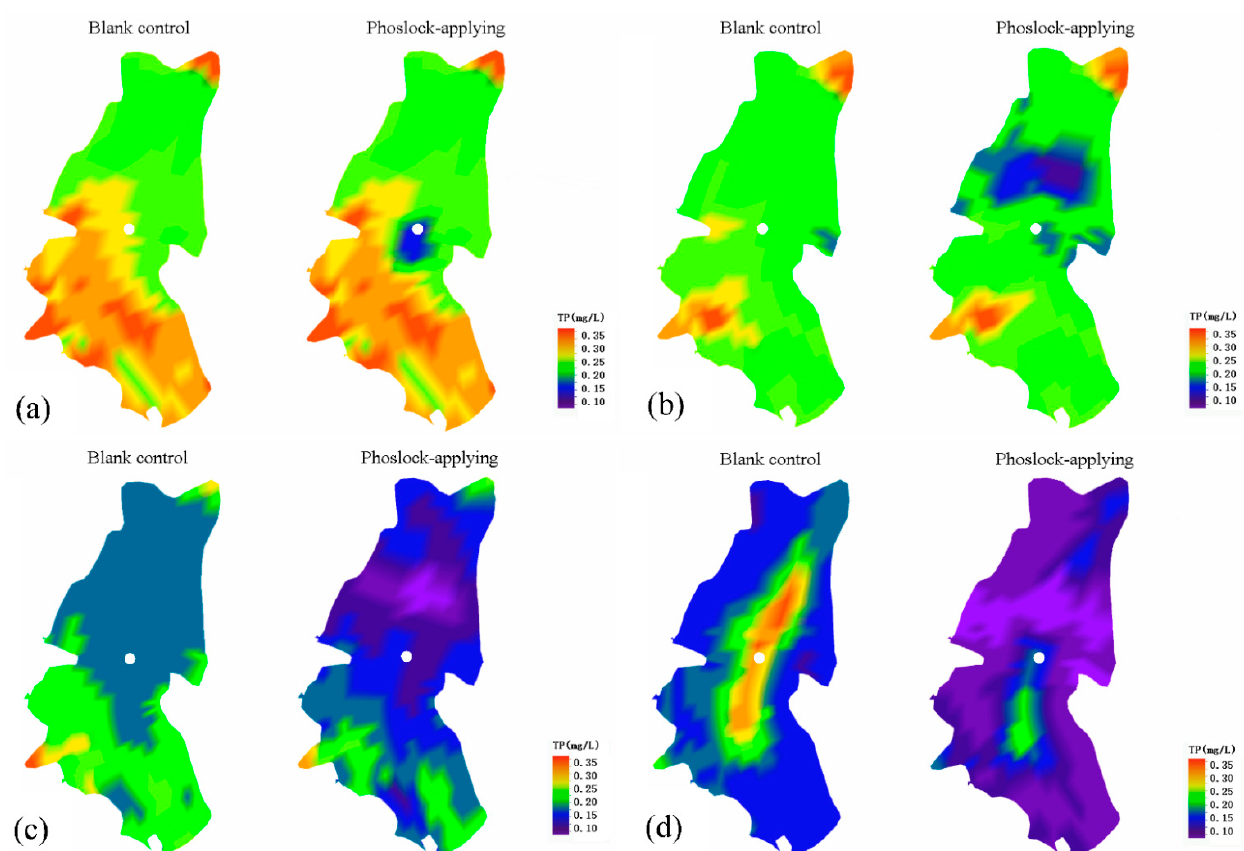
Figure 9. Spatial distribution of TP concentration at different moments during the Phoslock release cycle (base0-T1-A0-300t): ( a ) 1st day, ( b ) 5th day, ( c ) 15th day, and ( d ) 30th day.